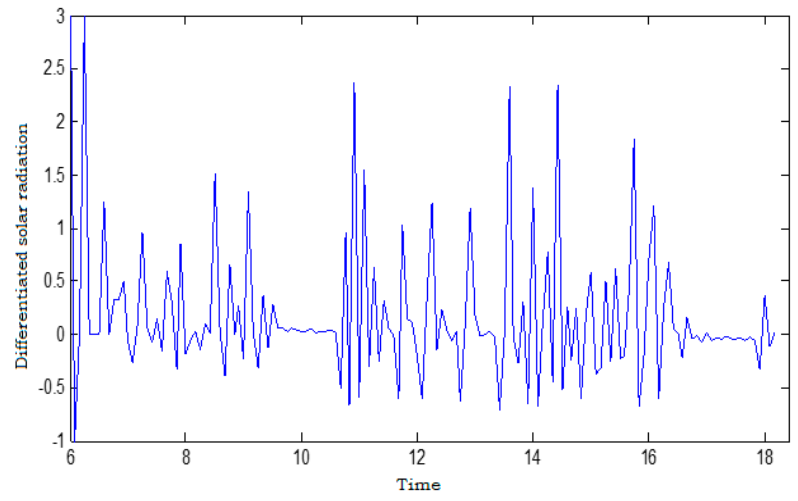
Figure 9. Relative differentiated solar radiation series for a summer day. Table 4. Parameters of the ARMA model for a summer day. ARMA (p,q) Orders